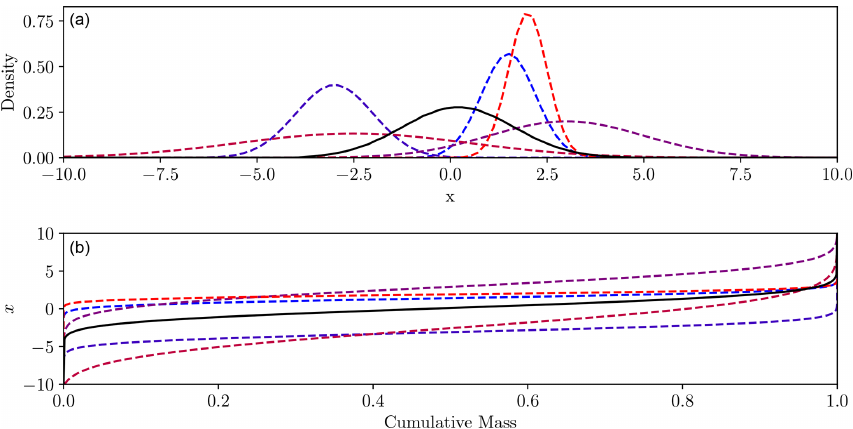
Figure 8. Method of finding the barycentre (solid black) from five Gaussian densities (dashed). Panel (a) shows density functions, panel (b) the inverse cumulative distributions. The mean of the inverse cumulative distributions is the cumulative distribution of the